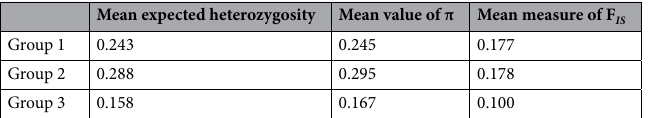
Table 3. Population genetic statistics.